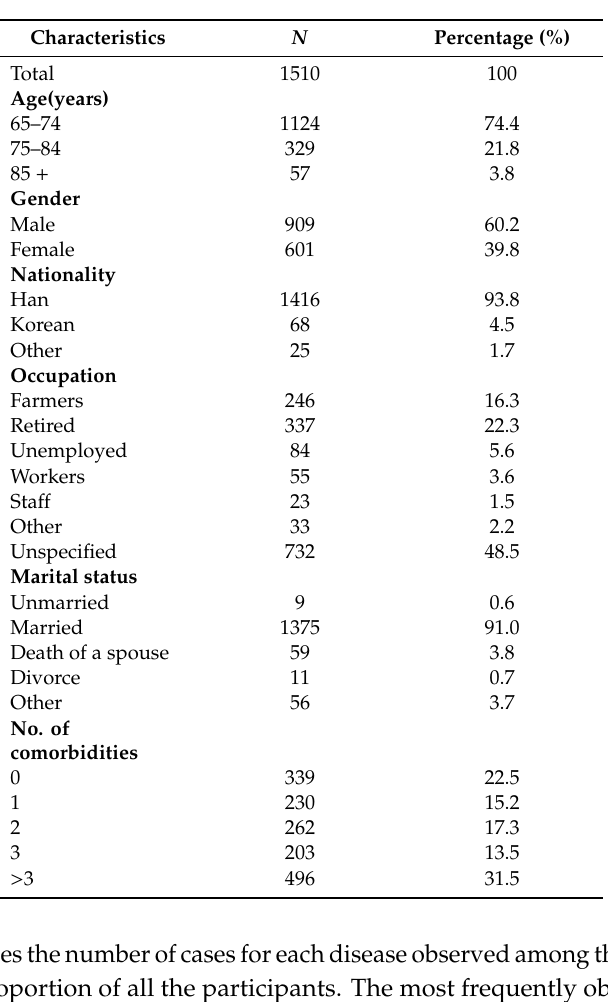
Table 1. Patient statistics.